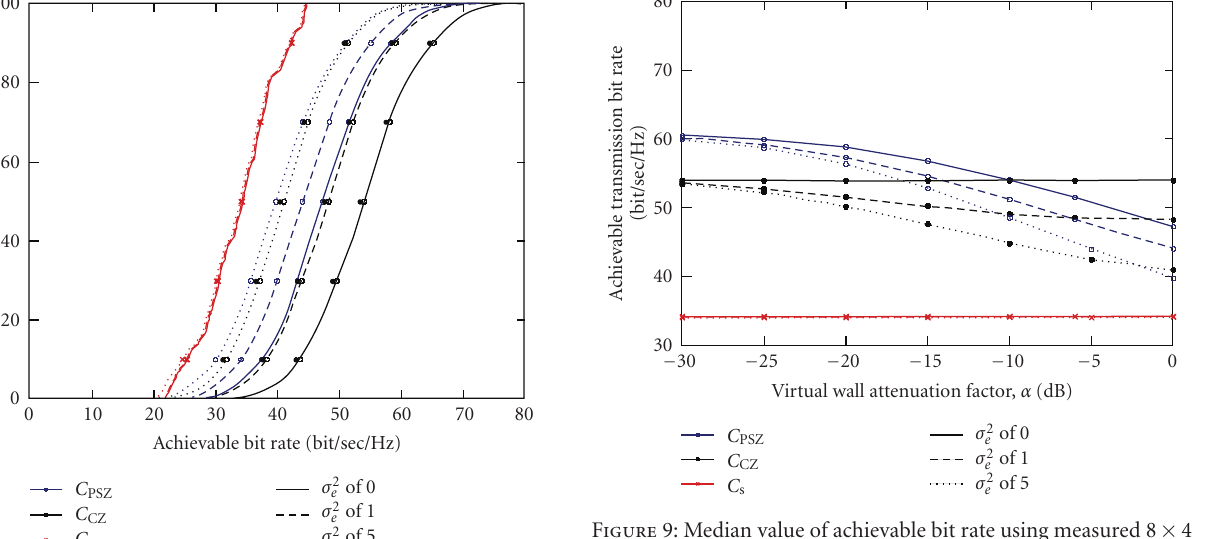
Figure 9: Median value of achievable bit rate using measured 8 × 4 channel matrices.